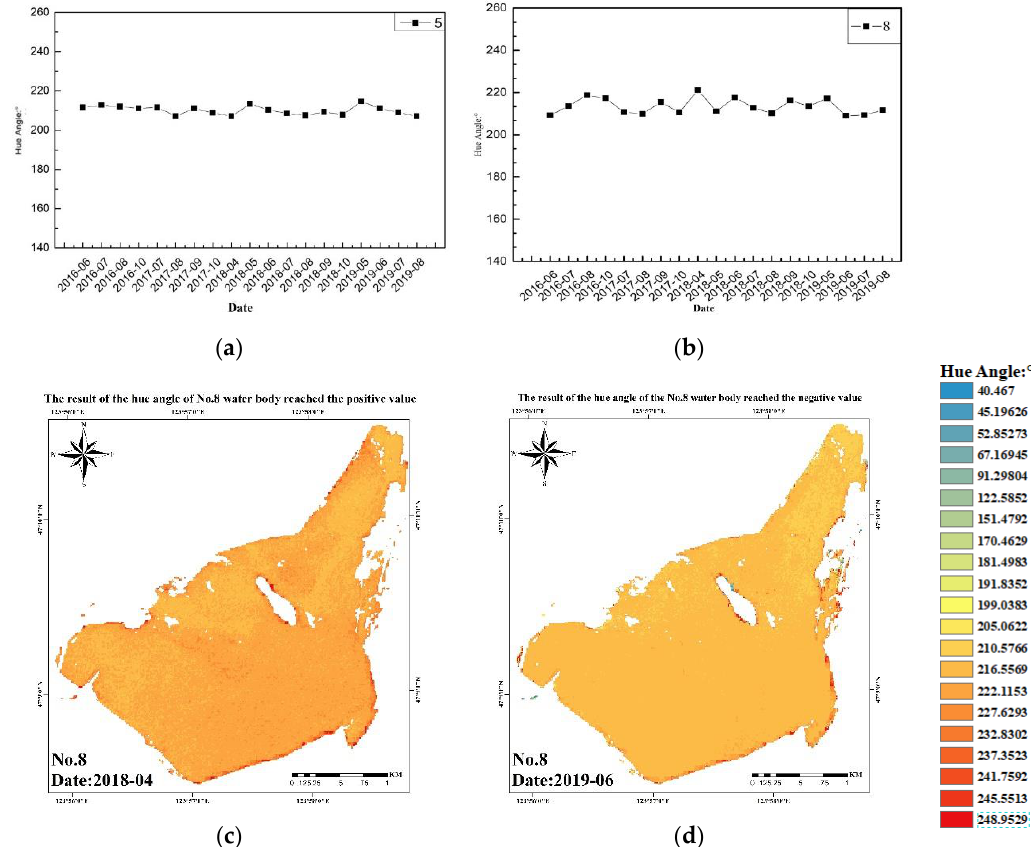
Figure 11. Statistics of water body hue angle changes in ( a ) water body No. 5 and ( b ) water body No. 8 in Qiqihar City from May 2016 to October 2019. ( c ) The highest hue angle of water body No. 8 was reached in April 2018. ( d ) The lowest hue angle of the same water body was reached in June 2019.